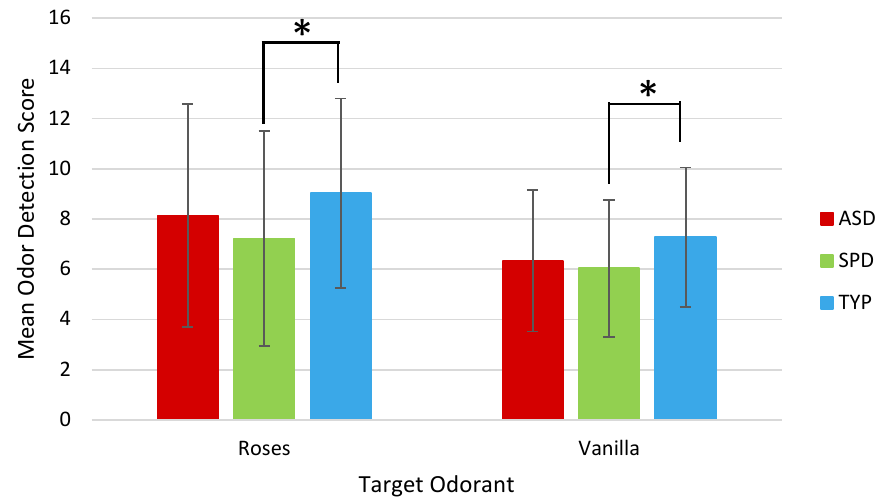
Figure 2. Mean odor detection threshold scores by group, as measured by Sniffin’ Sticks Odor Detection Threshold Test for target odors of Roses and Vanilla. Higher threshold scores represent detection at lower odorant concentration. Error bars indicate standard deviation. (*) denotes significant at p < 0.05. ASD = children with Autism Spectrum Disorder; SPD = children with demonstrated Sensory Processing Dysfunction; TYP = Typically Developing children.